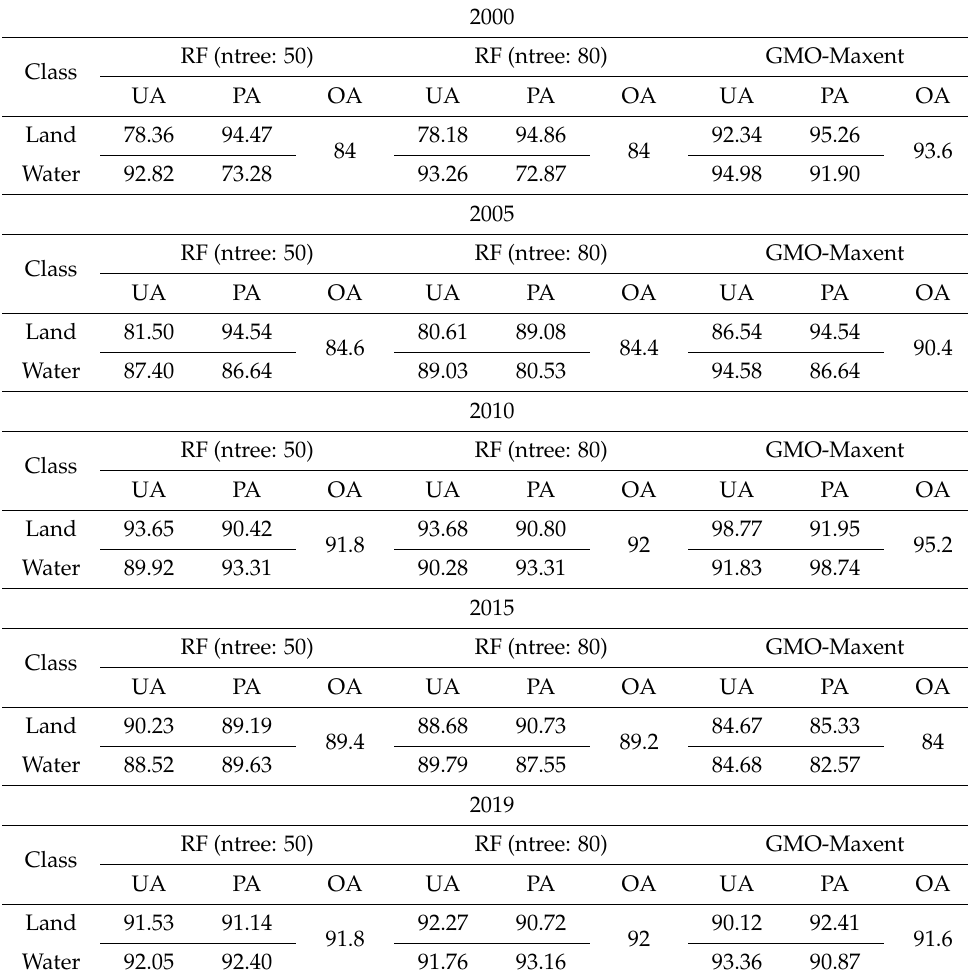
Table 2. Summary of the accuracy assessment results (in percentage) of the RF and GMO-Maxent